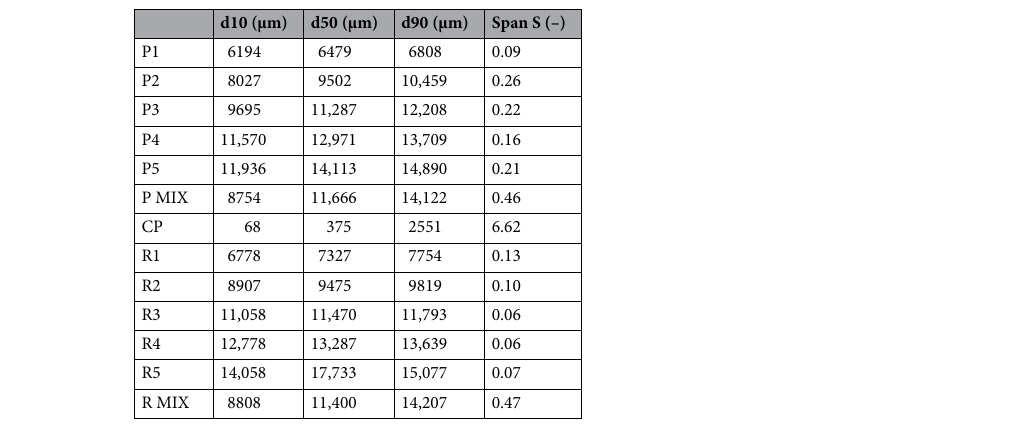
Table 3. Characteristics values for the particle size